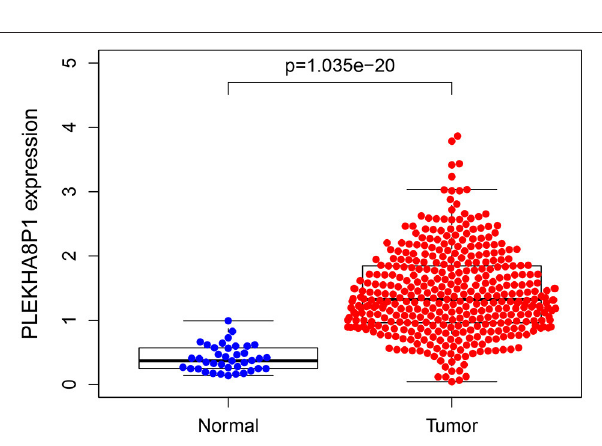
FIGURE 3 | Expression level of PLEKHA8P1 in colon tumors and normal